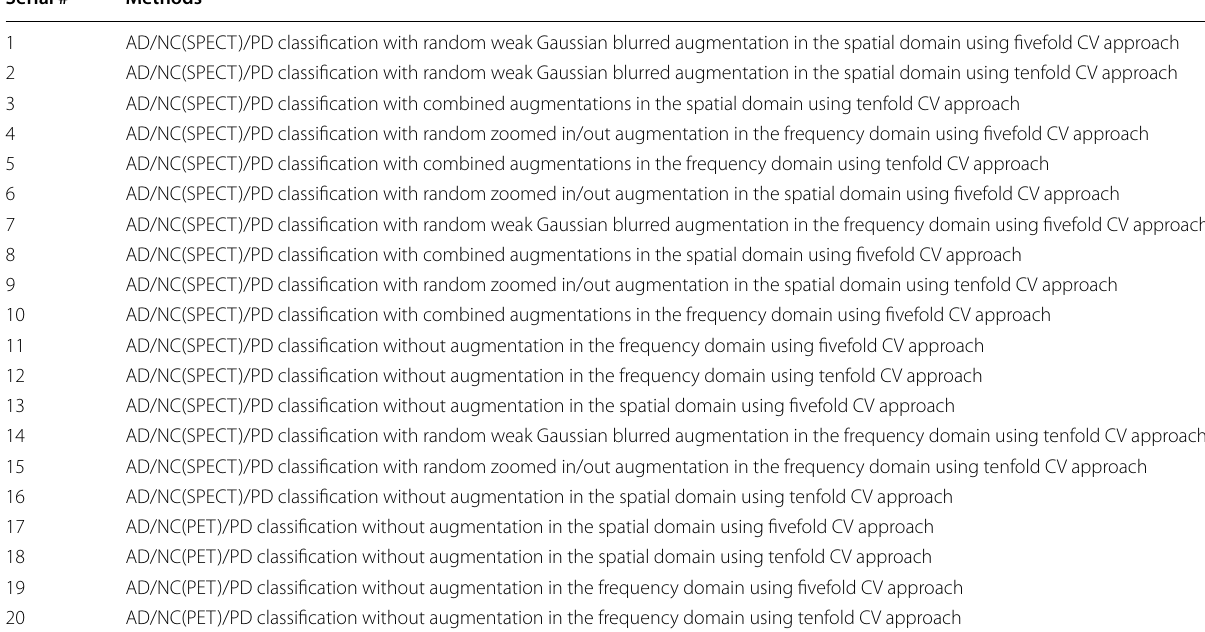
Table 4 A description of methods employed in the study